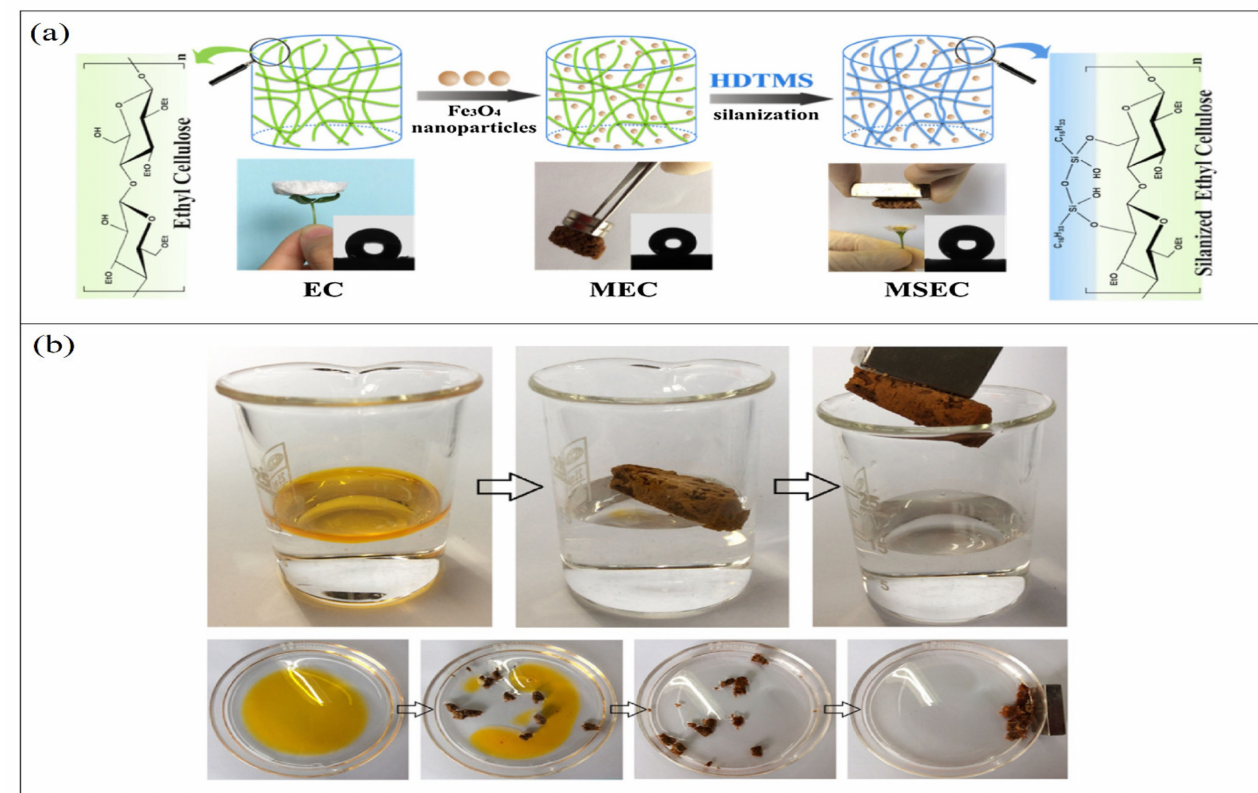
Figure 6. Illustration of modified ethyl cellulose magnetic aerogel: ( a ) schematic drawing of fabrica- tion approach; ( b ) selective oil absorption and magnetic-responsive character. Adapted from [102], with permission from Elsevier,